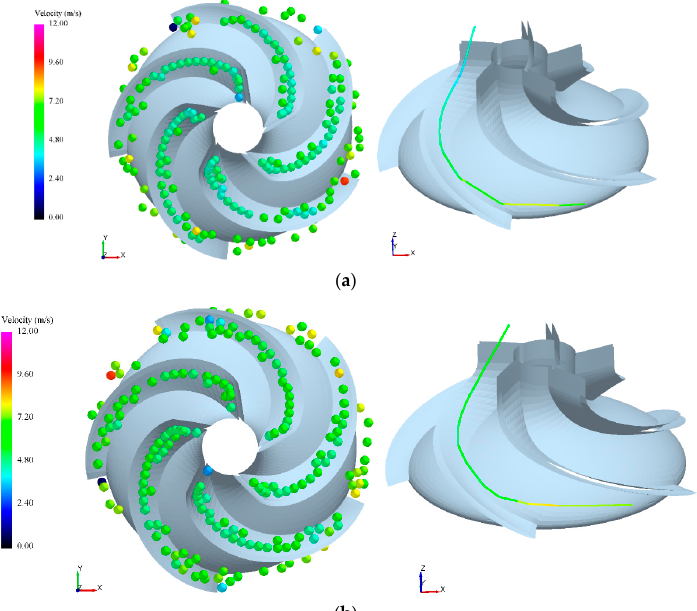
Figure 16. The left picture shows the distribution of particles at 1.2 s, and the right picture shows the trajectory of a certain particle. Color indicates the velocity of particles: ( a ) particles in the first-stage bowl diffuser; ( b ) particles in the second-stage bowl diffuser.